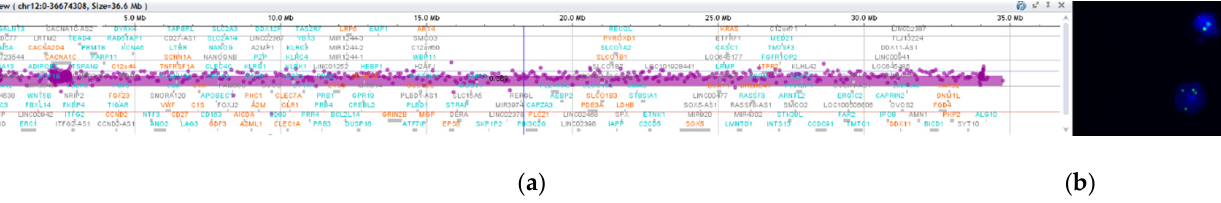
Figure 6. Genetic tests for patient 3: ( a ) array CGH result—DNA extracted from a peripheral blood; ( b ) interphase FISH—peripheral blood.